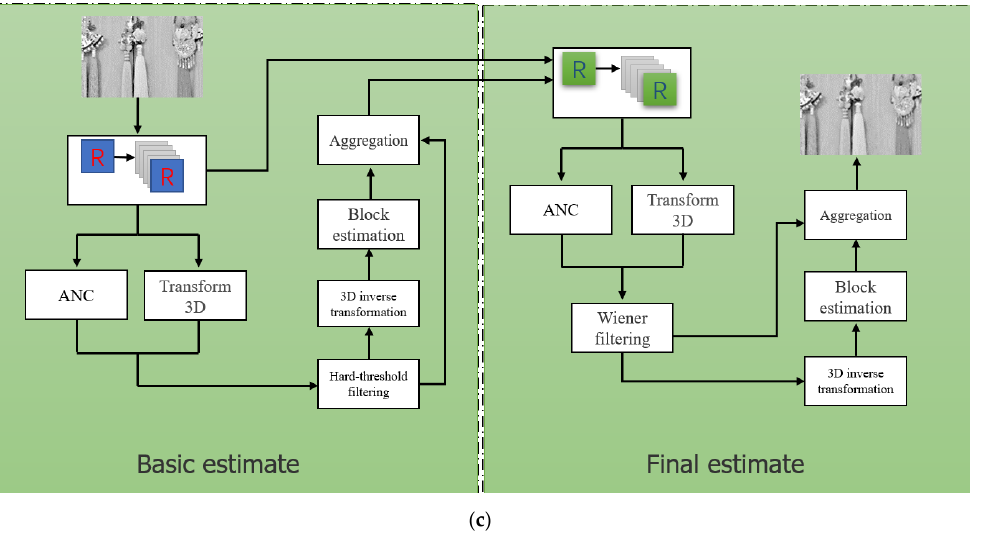
Figure 1. Schematic diagram of the network structure. ( a ) Schematic diagram of algorithm structure; ( b ) Enhancement Net; ( c ) Denoising Net.